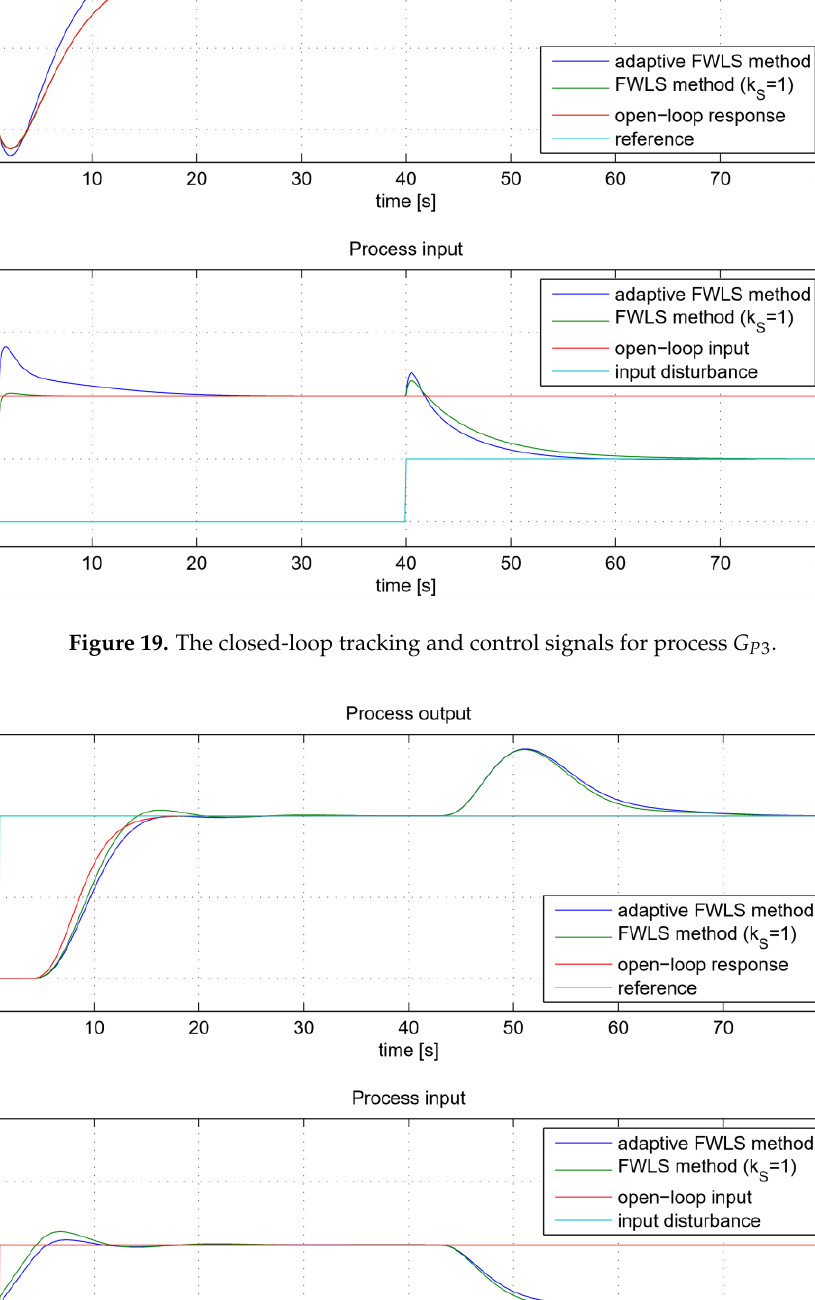
Figure 18. The closed-loop tracking and control signals for process G P 2 .